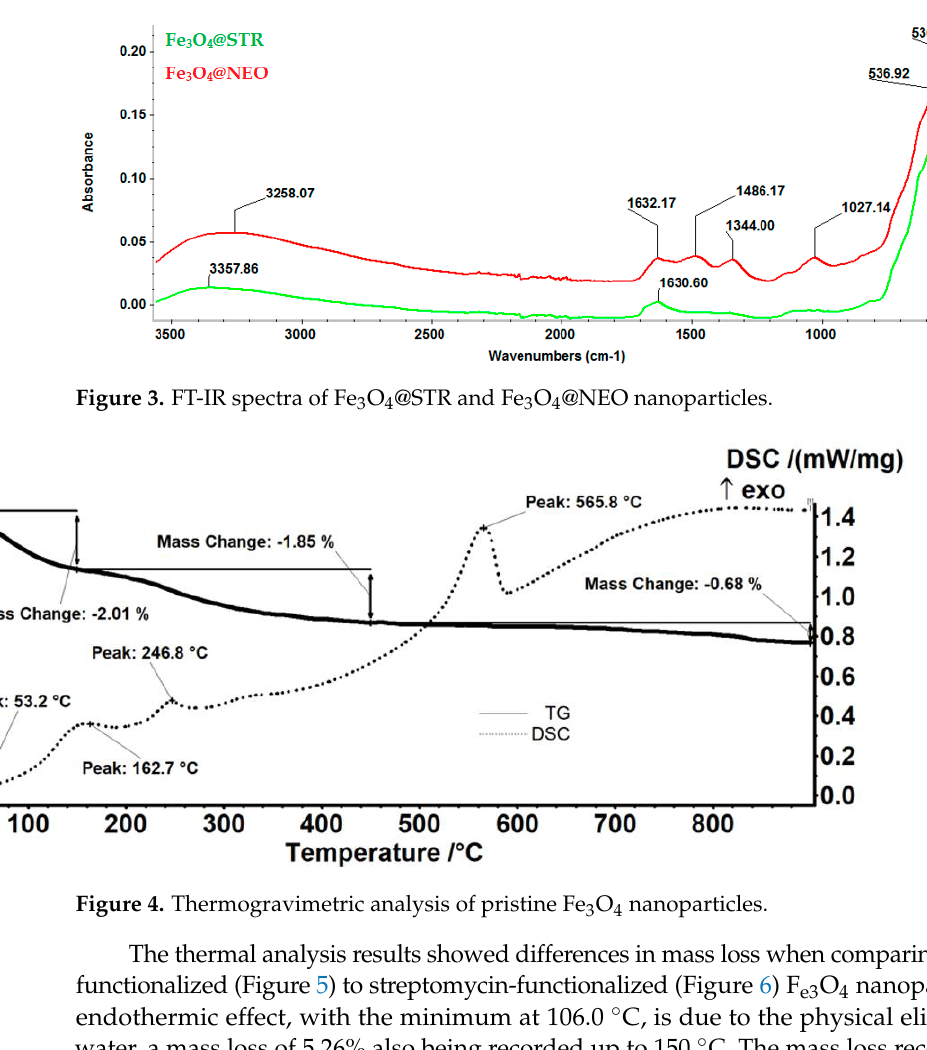
Figure 2. TEM images of ( a , c ) Fe 3 O 4 @NEO, ( b , d ) Fe 3 O 4 @STR; SAED patterns of ( e ) Fe 3 O 4 @NEO, ( f ) F e3 O 4 @STR nanoparticles; histograms of ( g ) Fe 3 O 4 @NEO, ( h ) F e3 O 4 @STR nanoparticles.